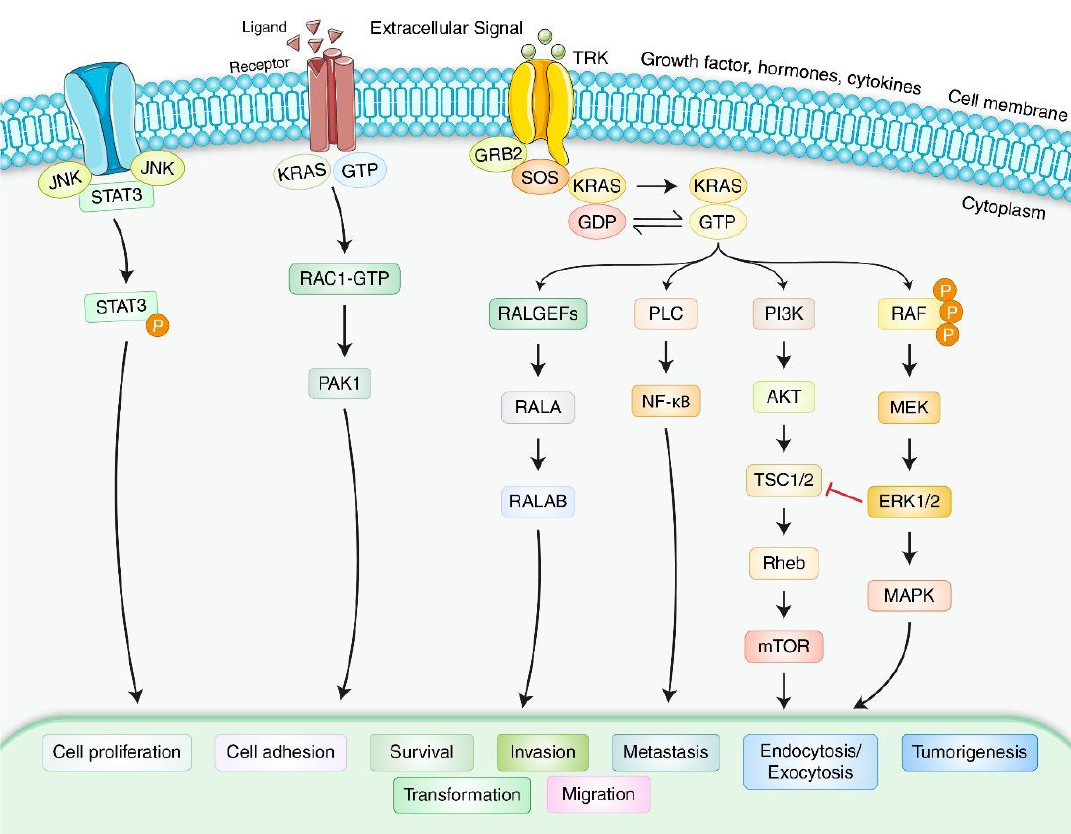
Figure 2. Formation of PC via several signaling pathways. Receptor tyrosine kinases (TRK) employ KRAS guanine nucleotide exchange factors (GEFs) such as son-of-sevenless (SOS) to activate GEFs and GTPase activating proteins (GAPs) that convert KRAS between its GTP- and GDP-bound states. The constitutive GDP-bound state triggers numerous downstream molecules in PDAC, leading to proliferation, invasion, metastasis, tumorigenesis, and migration. Ligand-mediated receptor KRAS-RAC1-GTP and JNK-STAT3 signaling are involved in activating PDAC.